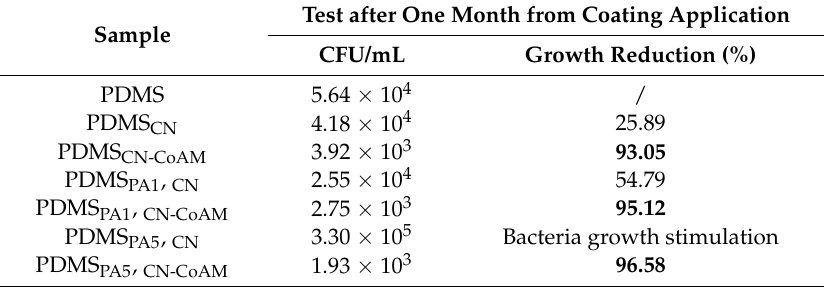
Table 6. Microbiological results of reduced bacterial growth at different silicone samples surfaces after 1